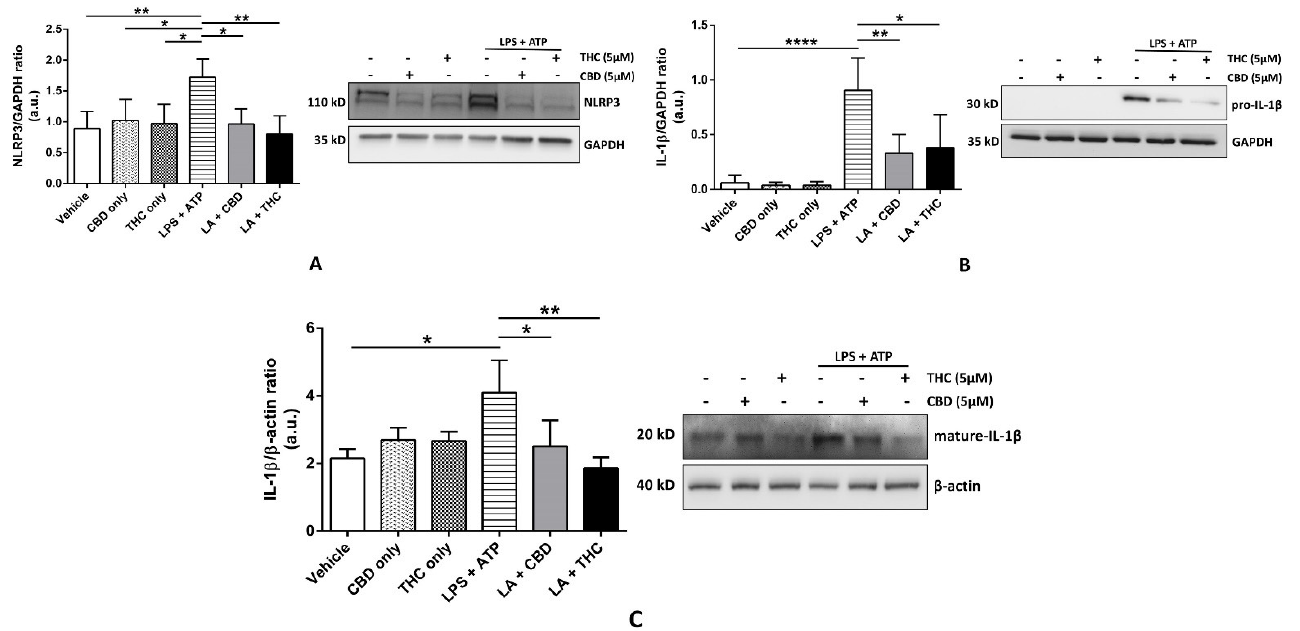
Figure 2. Effect of cannabinoids on the expression of NLRP3 inflammasome proteins in primary human bronchial epithelial cells. ( A ): CBD and THC decreased the expression of NLRP3 after LPS + ATP stimulation in primary HBEC: Representative Western blots of NLRP3 and GAPDH bands and the quantification of the same using one-way ANOVA with Tukey’s multiple-comparison test. Four independent experiments ( n = 4) of primary human bronchial epithelial cell lysates obtained after pre-treatment with CBD or THC for 30 min and LPS stimulation for 8 h followed by ATP for 1 h were analyzed, and data are expressed as means ± SD; * p < 0.05, ** p < 0.01. (Abbreviations: HBECs: Human bronchial epithelial cells; LA: LPS + ATP). ( B ): CBD and THC decreased the expression of pro-IL-1 β after LPS + ATP stimulation in primary HBECs: Representative Western blots of pro-IL-1 β and GAPDH bands and the quantification of the same using one-way ANOVA with Tukey’s multiple-comparison test. Four independent experiments ( n = 4) of primary human bronchial epithelial cell lysates obtained after pre-treatment with CBD or THC for 30 min and LPS stimulation for 8 h followed by ATP for 1 h were analyzed, and data are expressed as means ± SD; * p < 0.05, **